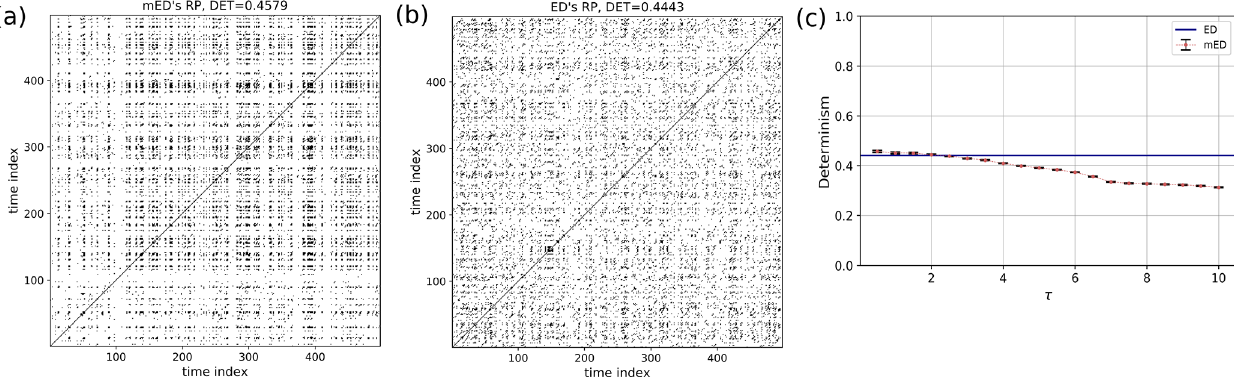
Figure 8. RP of a homogeneous Poisson process (Fig. 7a) using (a) mED and (b) ED; (c) comparison of DET for 300 realizations using ED (blue horizontal line) and using mED for varying τ in the range 0 to